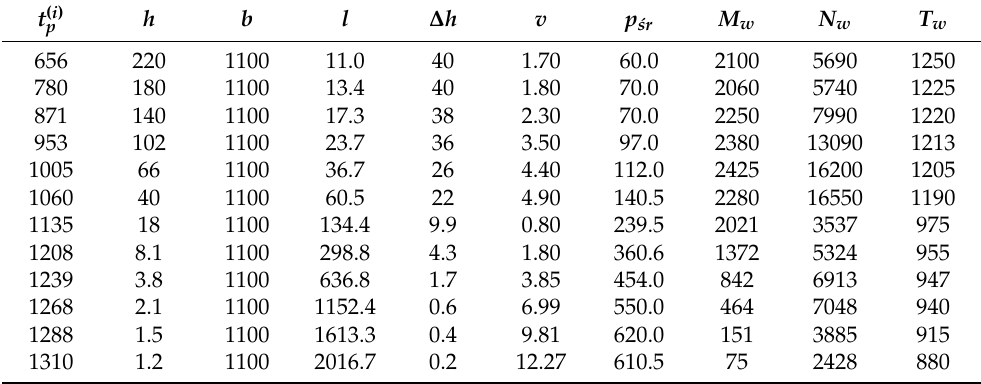
Table A1. An example of selected data used to develop the model during the implementation of the first rolling